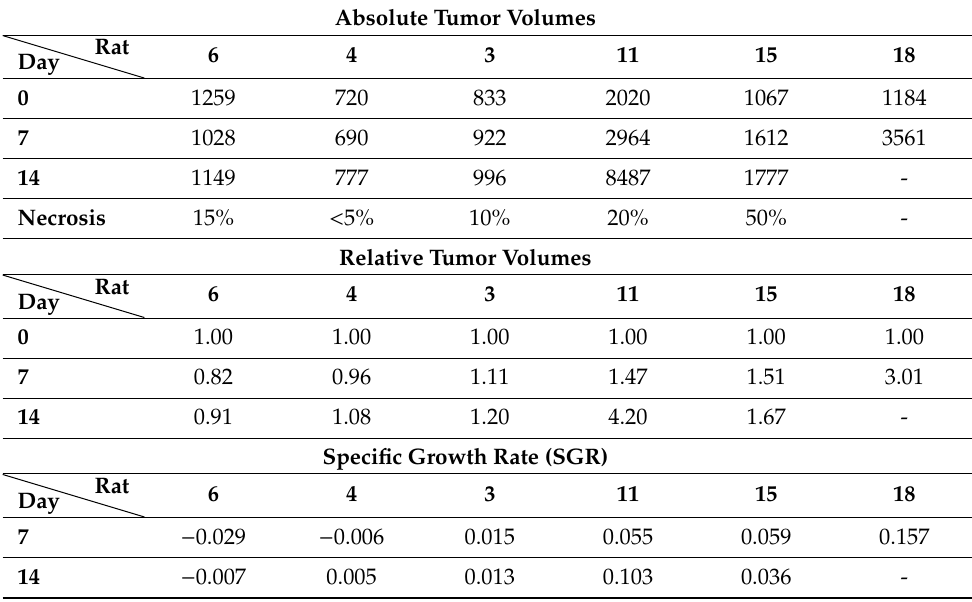
Figure 4. Individual tumor growth curves showing absolute tumor volumes over days after treatment: ( a ) West diet with ECT with intratumoral curcumin (EP + Cur) treatment, ( b ) W + Cur diet with EP + Cur treatment. Table 2. Quantitative characterization of tumor growth for rats on West diet with EP + Cur treatment. The relative tumor volumes and specific growth rate (SGR) were calculated for days 7 and 14 after treatment, compared to the tumor volume before start of the treatment (at day 0).